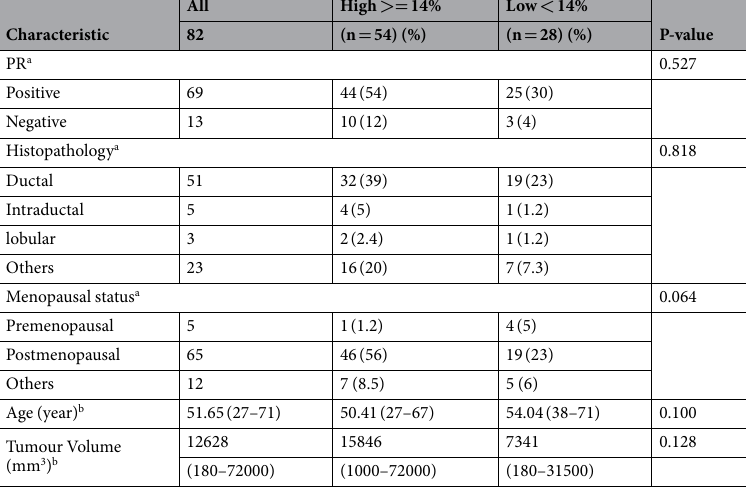
Table 1. Tumour characteristics. a Data were tested using the Fisher’s exact test. b Data were tested using